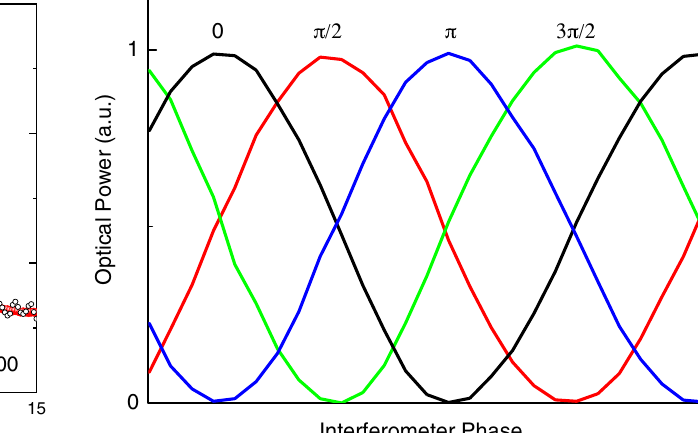
FIG. 5. Optical output power as a function of the operation temperature of the phase-preparation laser. The pulse-generation laser temperature is fixed, and the optical injection power is 50 μ W. Also shown are the optical power in the absence of optical injection (blue line) and the optical reflection of the injected light measured with the pulse-generation laser switched off (open circles), multiplied by a factor of 1000 for clarity.